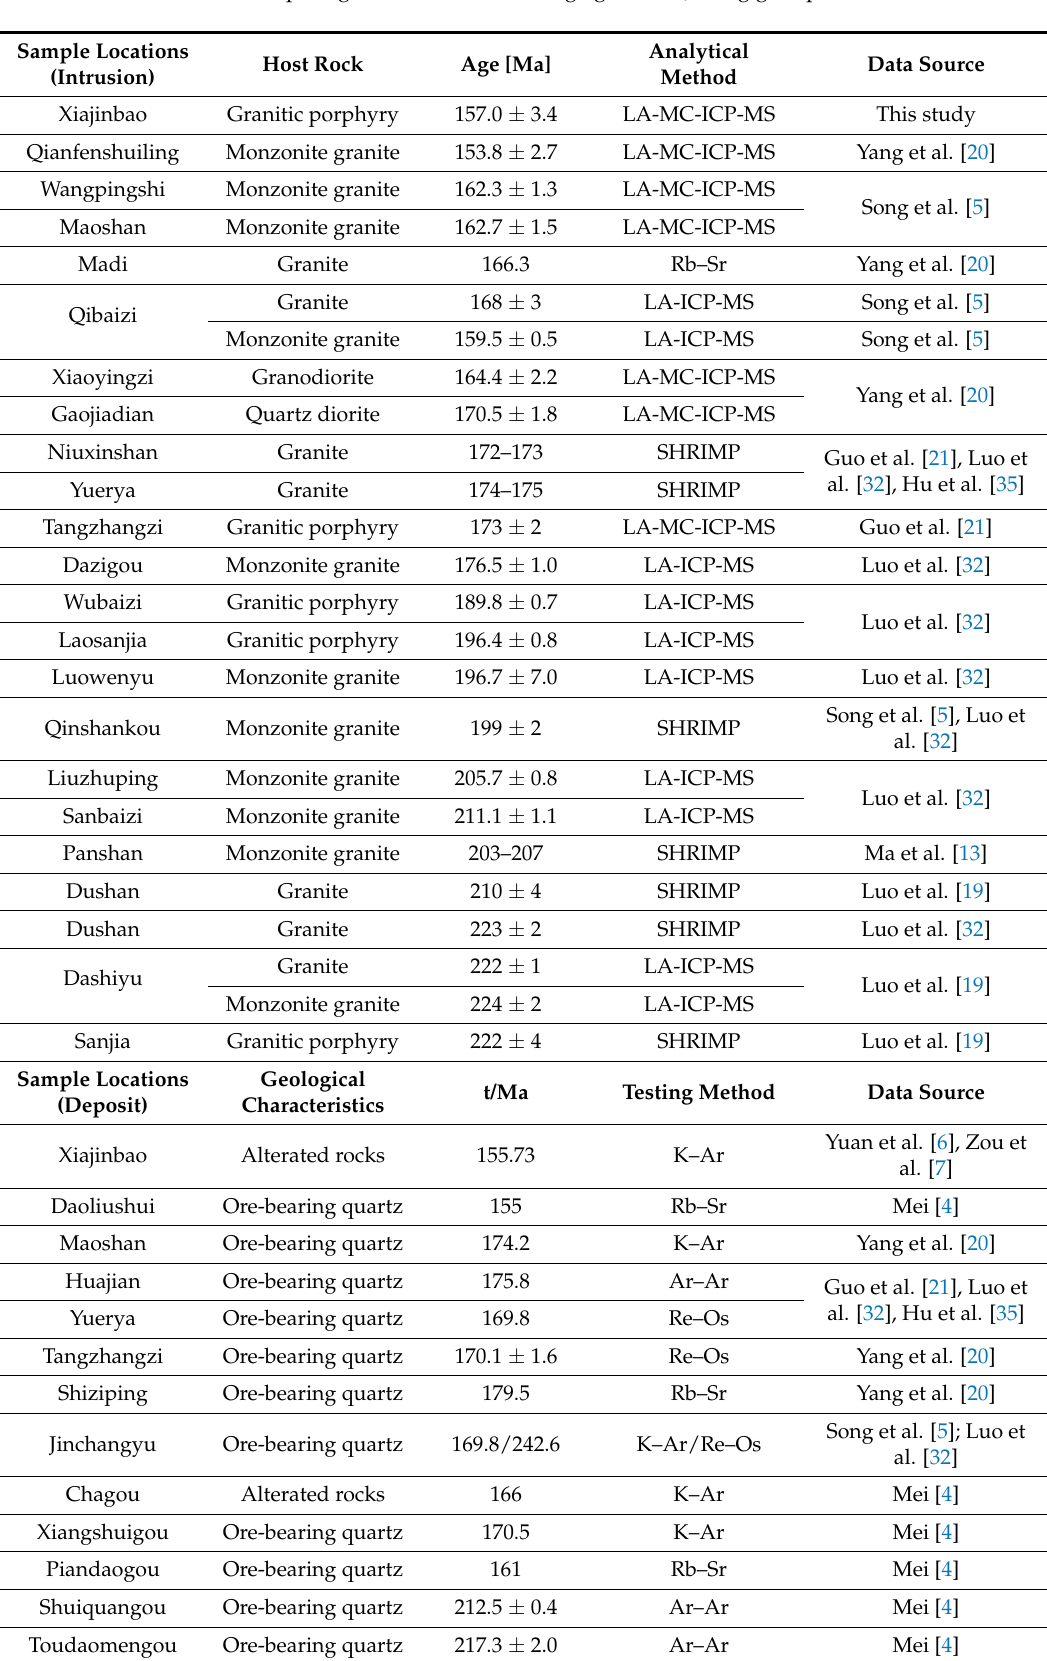
Table 11. The petrogenetic and ore-forming age in the Jidong gold